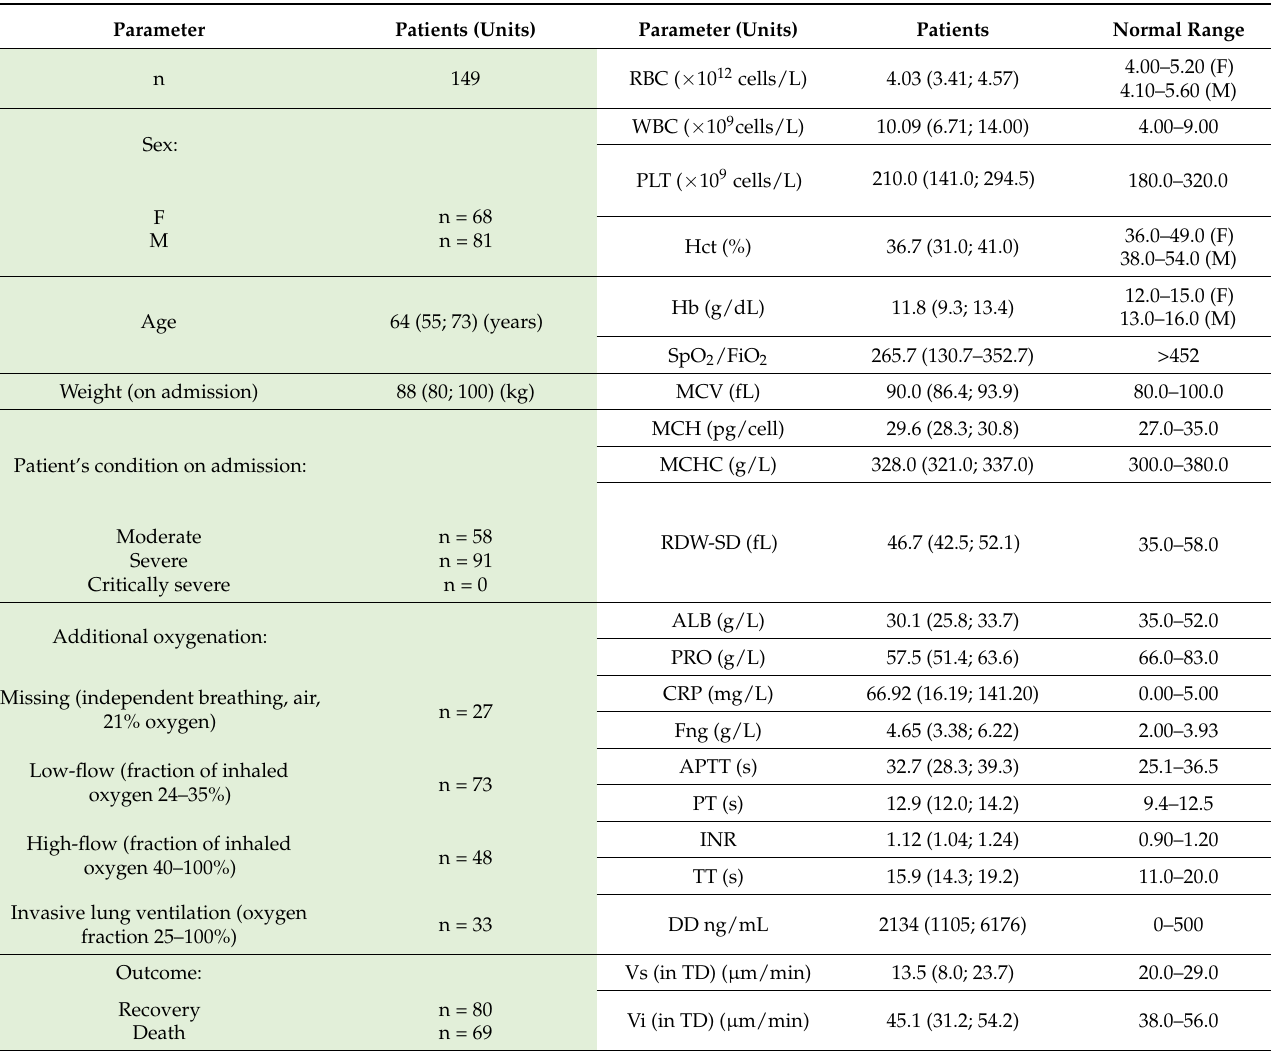
Table 1. Demographic composition and some parameters of patients’ condition